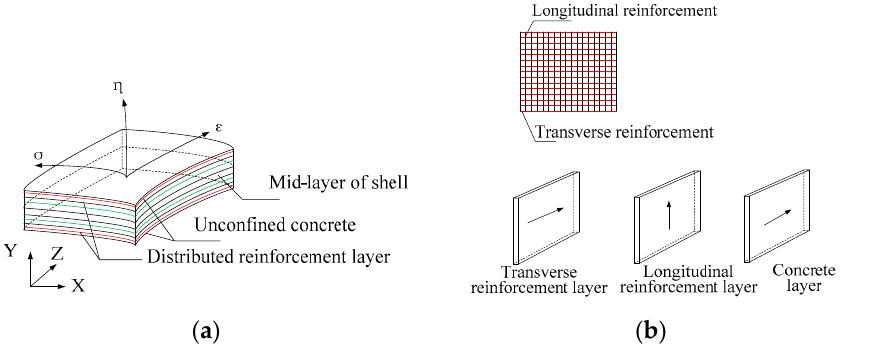
Figure 2. Multi-layer shell element model: ( a ) Multi-layer shell element; ( b ) Distribution of the rebar layer.